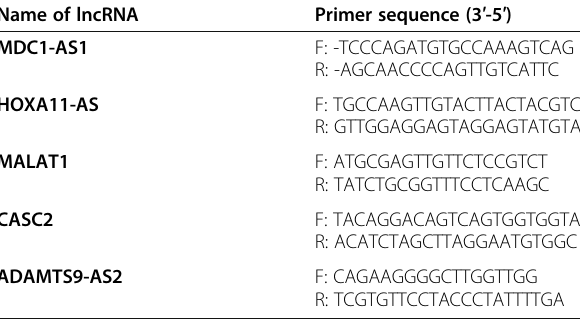
Table 1 Primers used in this study to amplify target genes Name of lncRNA